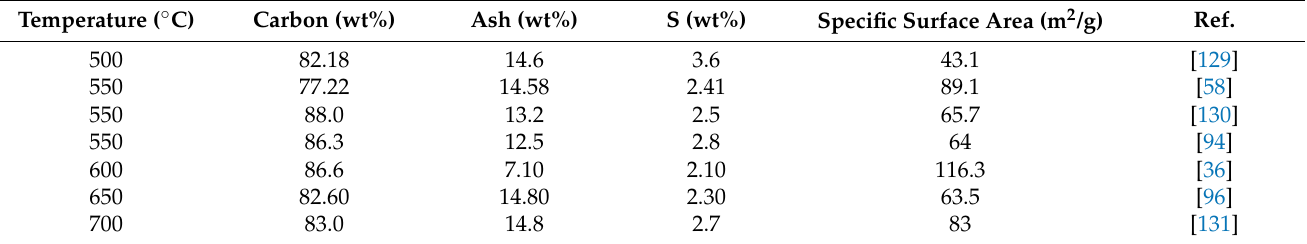
Table 5. Parameters of pyrolysis carbon black at different pyrolysis